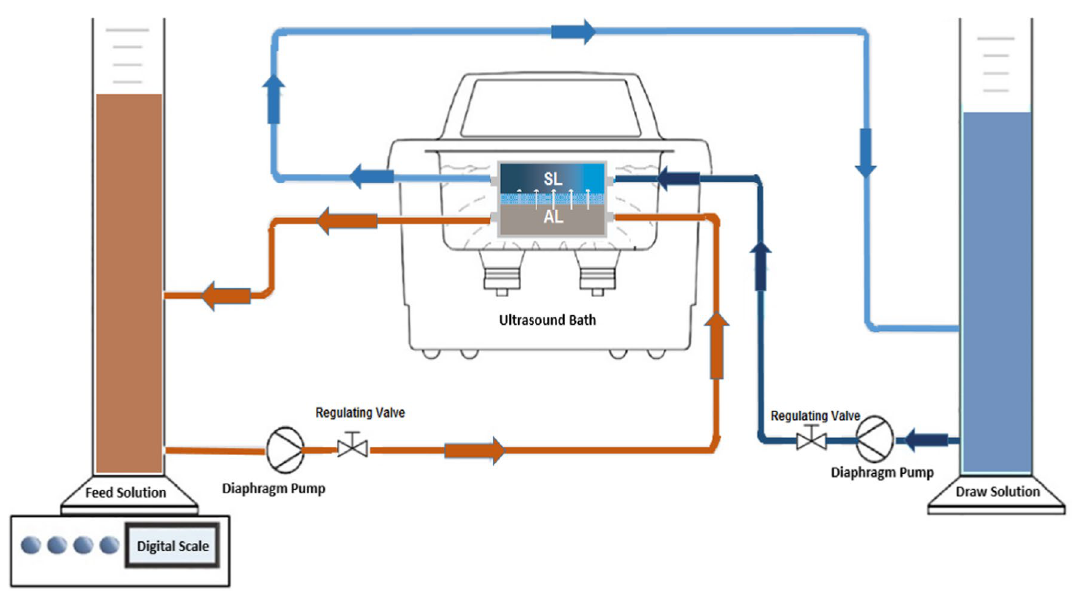
Fig. 1 Experimental setup arrangement for ultrasound-assisted FO process: AL-FS mode, co-current and the active layer (AL) faces the ultra- sound transducer (Al-Sakaji et al. 2022b)